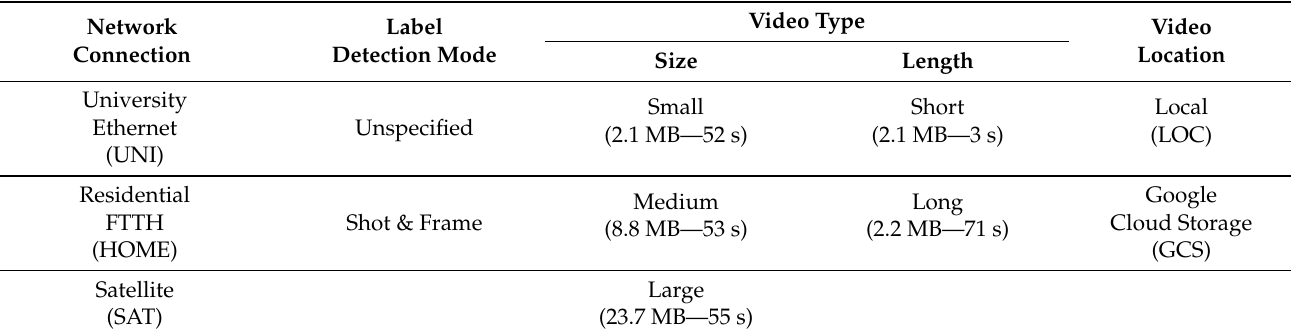
Table 2. Details of the variables considered in the experiments.